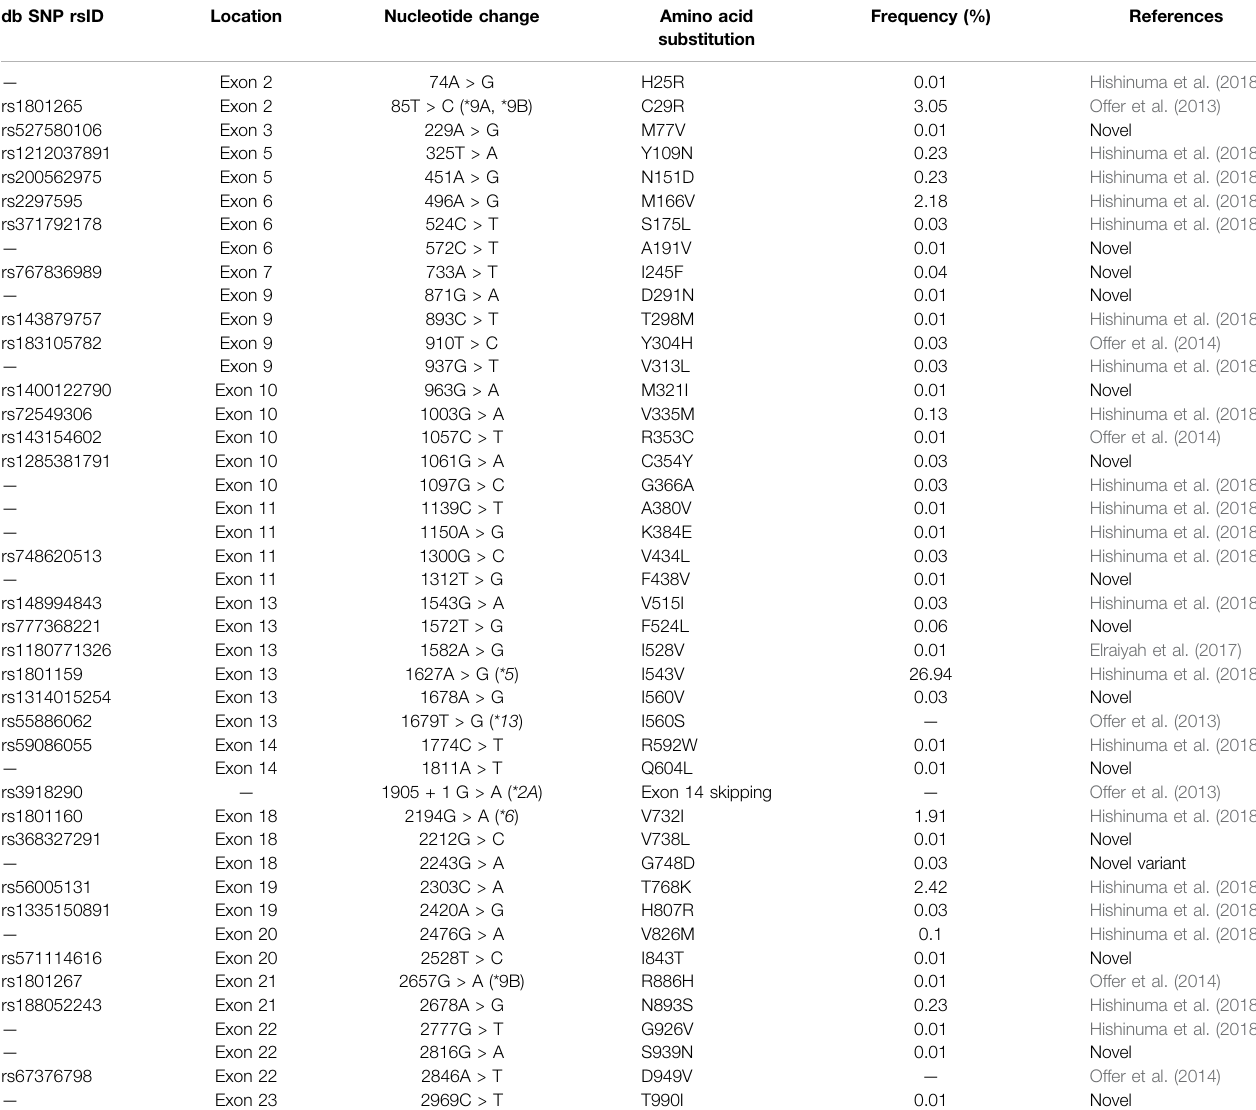
TABLE 1 | DPYD variants identi fi ed in 3,554 Japanese subjects and three risk variants. db SNP